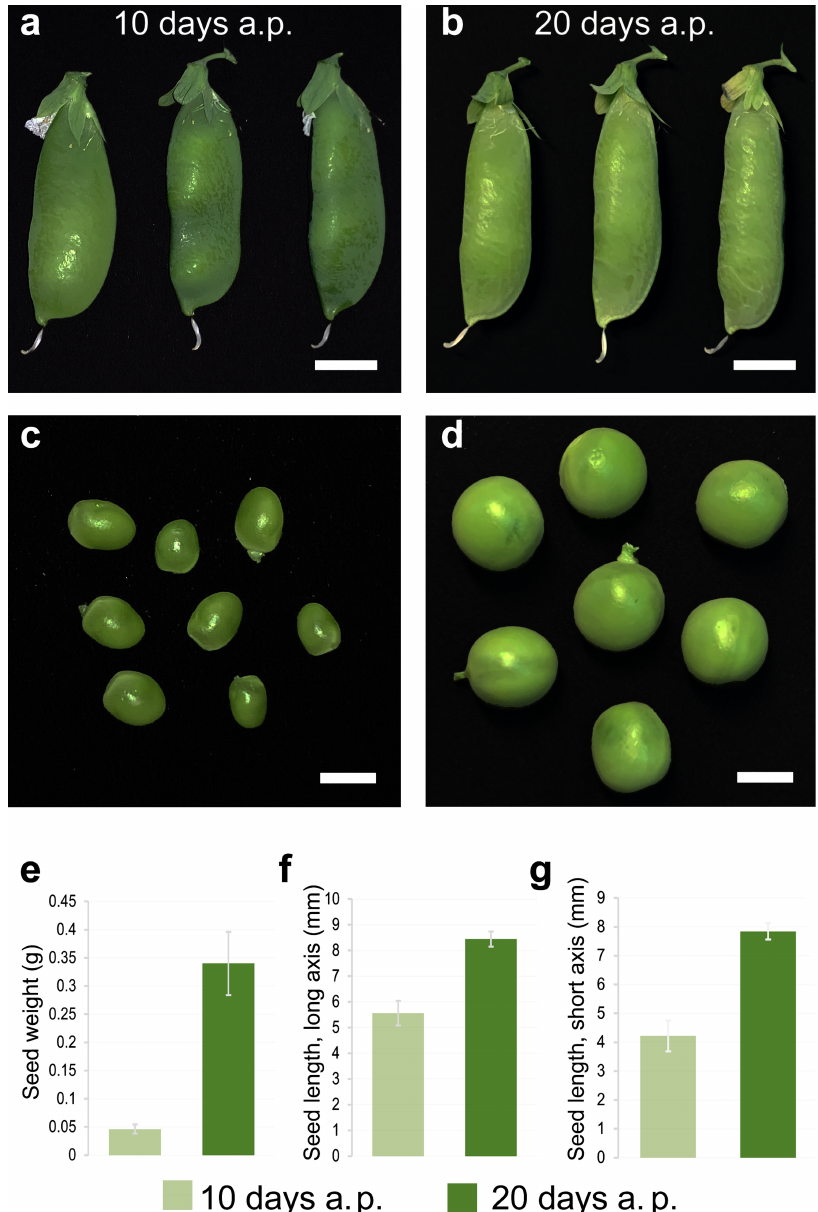
Figure 1. Morphometry of the Pisum sativum L. genetic line Sprint-2 seeds collected at 10 and 20 days after pollination (a.p.). ( a , b ) Pods are shown, scale bars are equal to 10 mm. ( c , d ) Seeds are shown, scale bars are equal to 5 mm. Average seed weights ( e ), where lengths along the long ( f ) and short ( g ) axes are shown. Data are presented as the means ± the standard